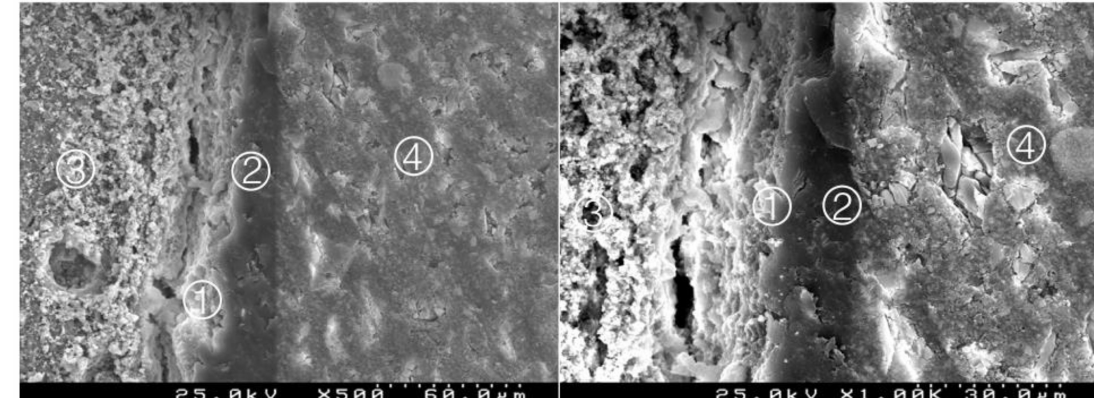
Figure 14. Group 12 (NeoMTASE17): some interdigitation between the adhesive system and CSC. A less deep or thinner interdiffusion layer is observed 1 (cid:13) between the adhesive 2 (cid:13) and the NuSmile ® NeoMTA 3 (cid:13) . Composite resin 4 (cid:13) (original magnification 500 × and 1000 × ).